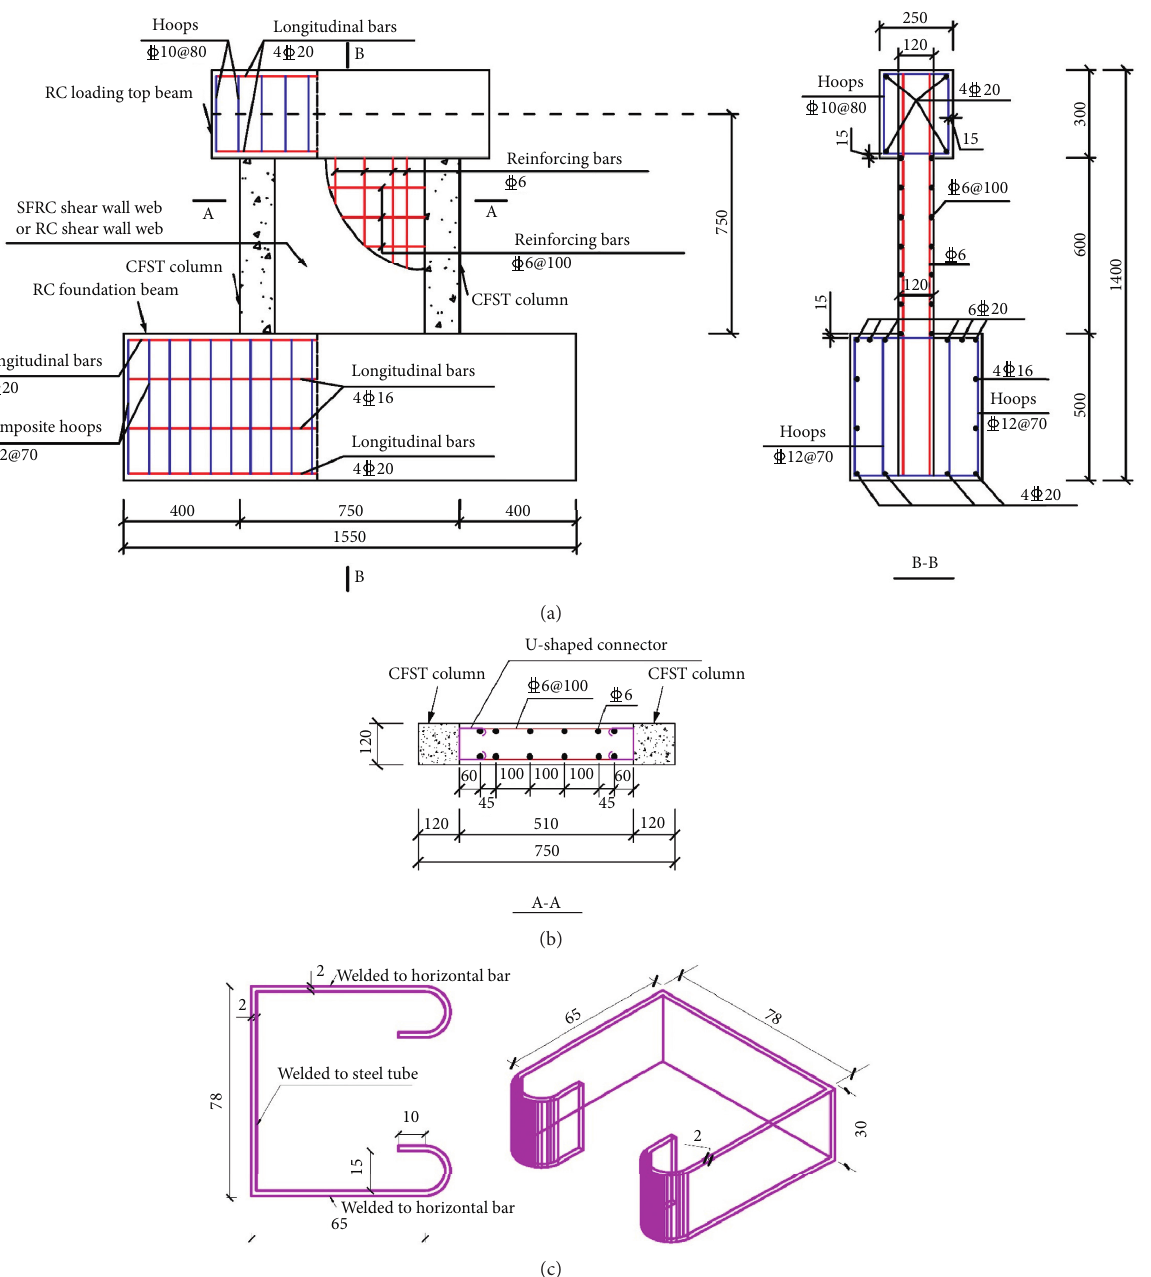
Figure 1: Specimen configuration (unit: mm). (a) Elevation. (b) A-A section. (c) One-dimensional and three-dimensional graph of U- shaped